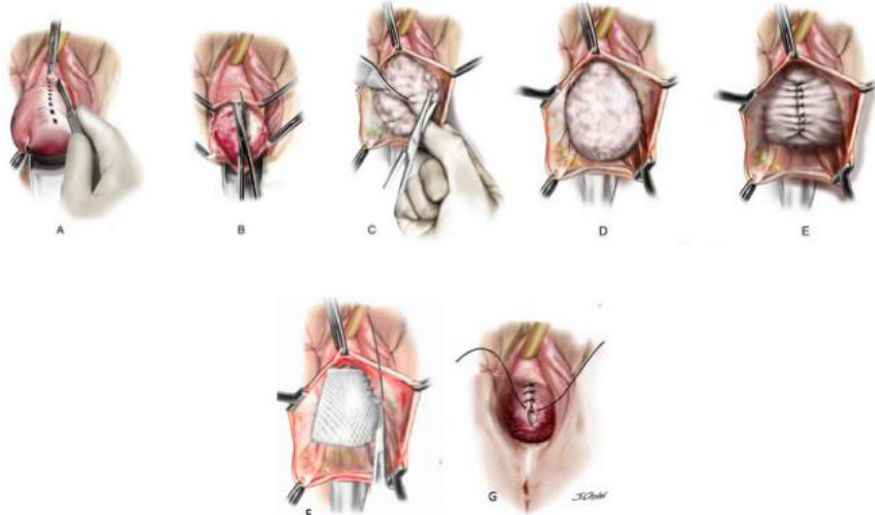
Figure 1. Illustration of a transvaginal anterior wall repair with a biologic graft [2]. ( A ) Incision into the anterior vaginal wall; ( B ) Incision into the anterior vaginal wall; ( C ) Dissection of the pubocervical fascia from the anterior vaginal wall; ( D ) Visualization of the defect; ( E ) Plication of the defect; ( F ) Anchorsure deployment bilaterally into the sacrospinous ligaments and arcus tendineus fascia pelvis, the prolene suture is pierced through the dermal bio-graft and tied down creating a lift and barrier between the bladder and anterior vaginal wall *; ( G ) Trimming and re-approximation of the vaginal tissue. * A demonstration and visualization of the Anchorsure is available at the following link: https://www.youtube.com/watch?v=9oBXxdRu5gk [3] (accessed on 23 October